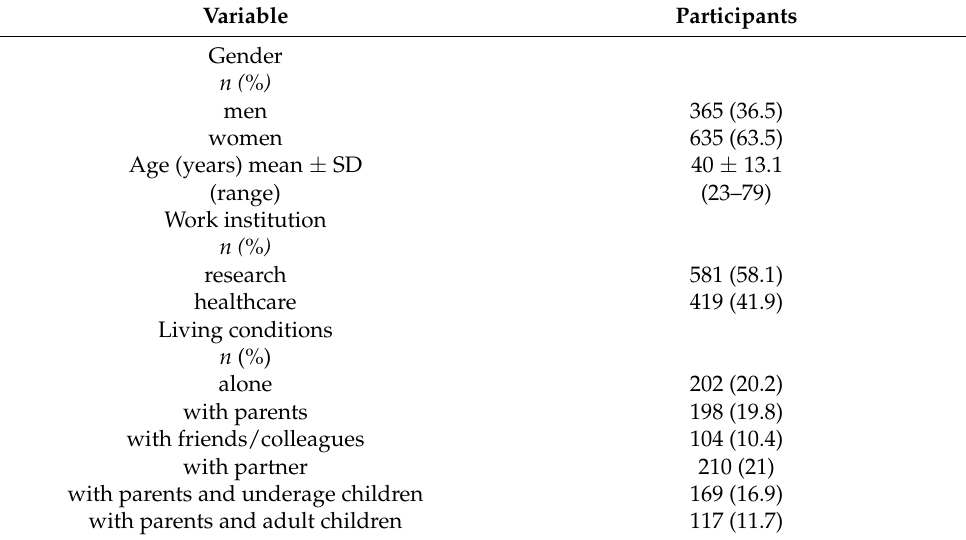
Table 1. Characteristics of participants ( n =